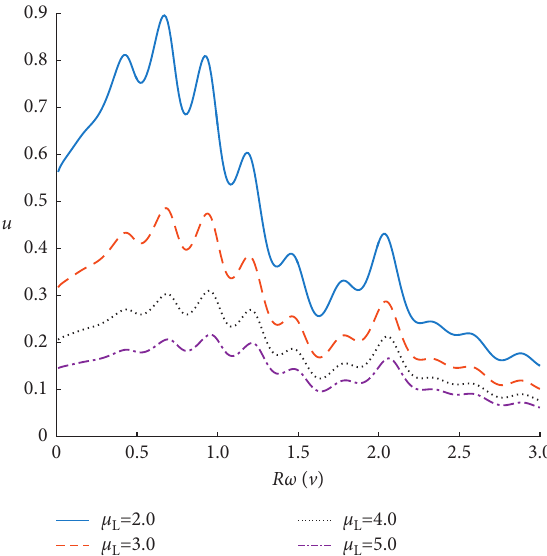
Figure 11: Curves of radial displacement varying with frequency for different shear modulus ratio of lining